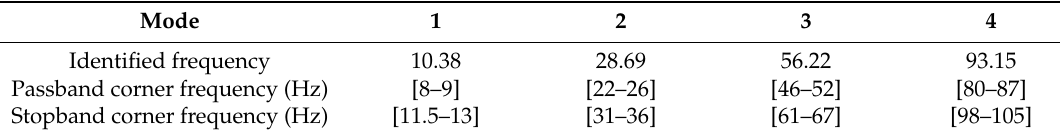
Table 1. Frequency ranges for each band-pass filters for the beam